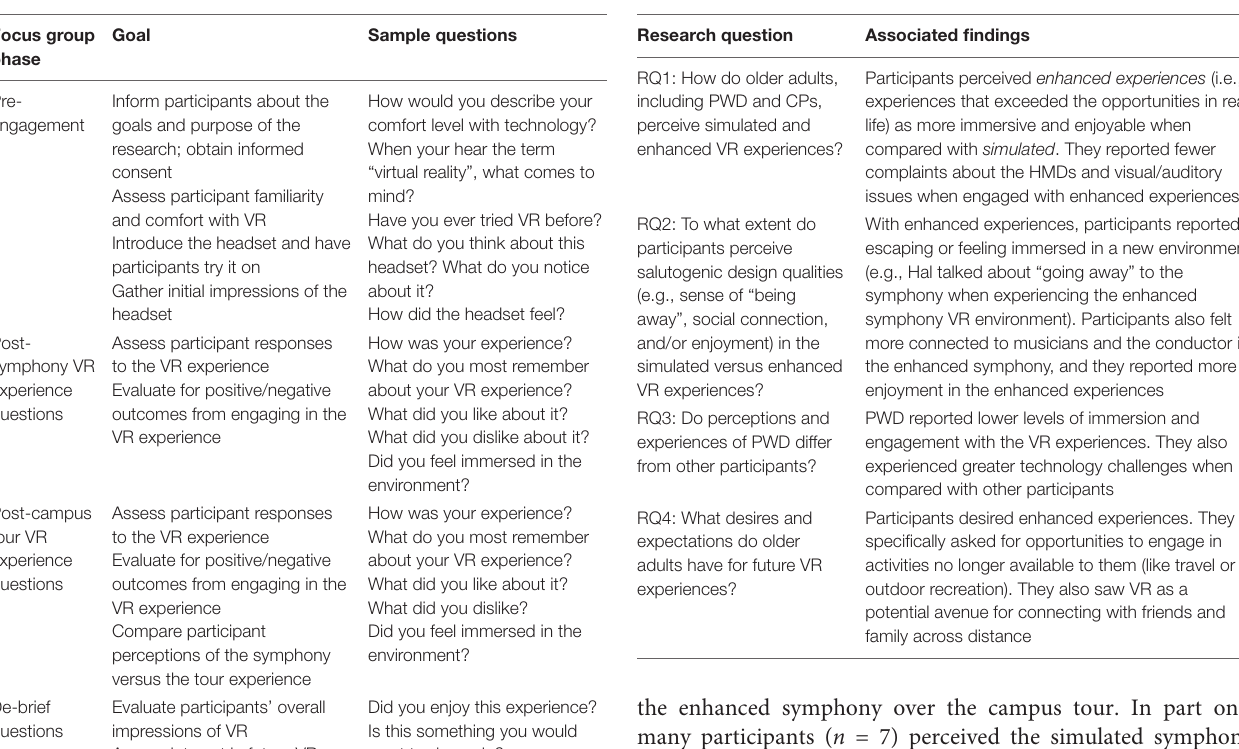
TABLE 3 | Focus group protocol and sample questions. TABLE 4 | Summary of research